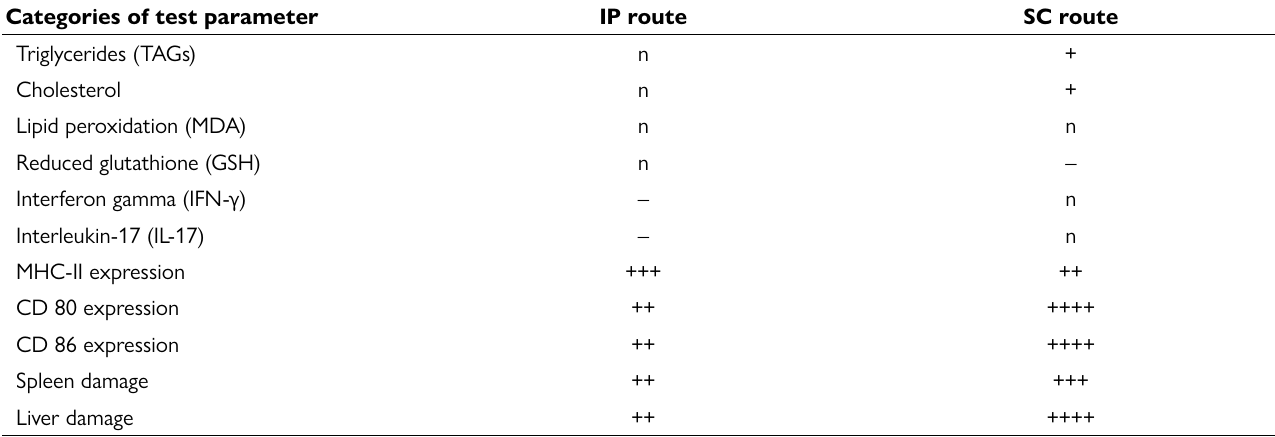
Table 1. Different categories of test parameters for intraperitoneal and subcutaneous routes of SAV injection in male